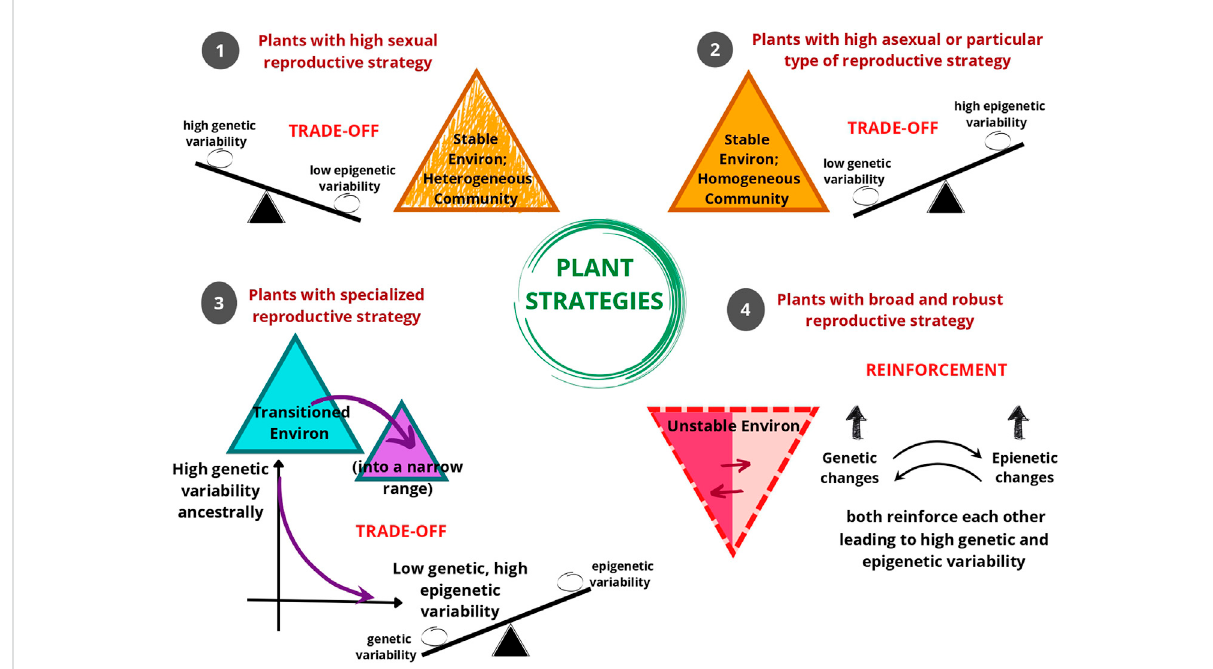
FIGURE 3 An illustration of the hypothesis that as a response to environmental conditions, different reproductive strategies of plants are associated with the coordination of genetic and epigenetic variability within the gene pool. Mostly, plant reproductive strategies show trade-offs, i.e. balancing of geneticandepigeneticvariability.Environmentalconditions(orEnviron) 1 , 2 ,and 3 showatrade-offbetweengeneticandepigeneticvariabilityinthe gene pool. In Environment ( 1 ), the environment is stable with a heterogenous plant community, where plants generally tend to reproduce sexually. In this type of environment, the plant tends to have high genetic variability and low epigenetic variability. In Environment ( 2 ), the environmentisstable withahomogeneousplantcommunity,where plants generally tendtoreproduceasexuallyoronlythroughself-pollination.In this type of environment, the plant tends to have high epigenetic variability and low genetic variability. In Environment ( 3 ), when the plant transitions into an environment that is peculiar in some characteristic then the plant tends to perform specialized reproductive strategy suited for that narrow- ranged environment. In this type of environment too, there is a trend of a decrease in genetic variability and an increase in epigenetic variability. In Environment ( 4 ) opportunistic or invasive plants with diverse (i.e. broad) and robust reproductive responses can survive in unstable or fl uctuating environments, here the genetic variability and epigenetic variability reinforce each